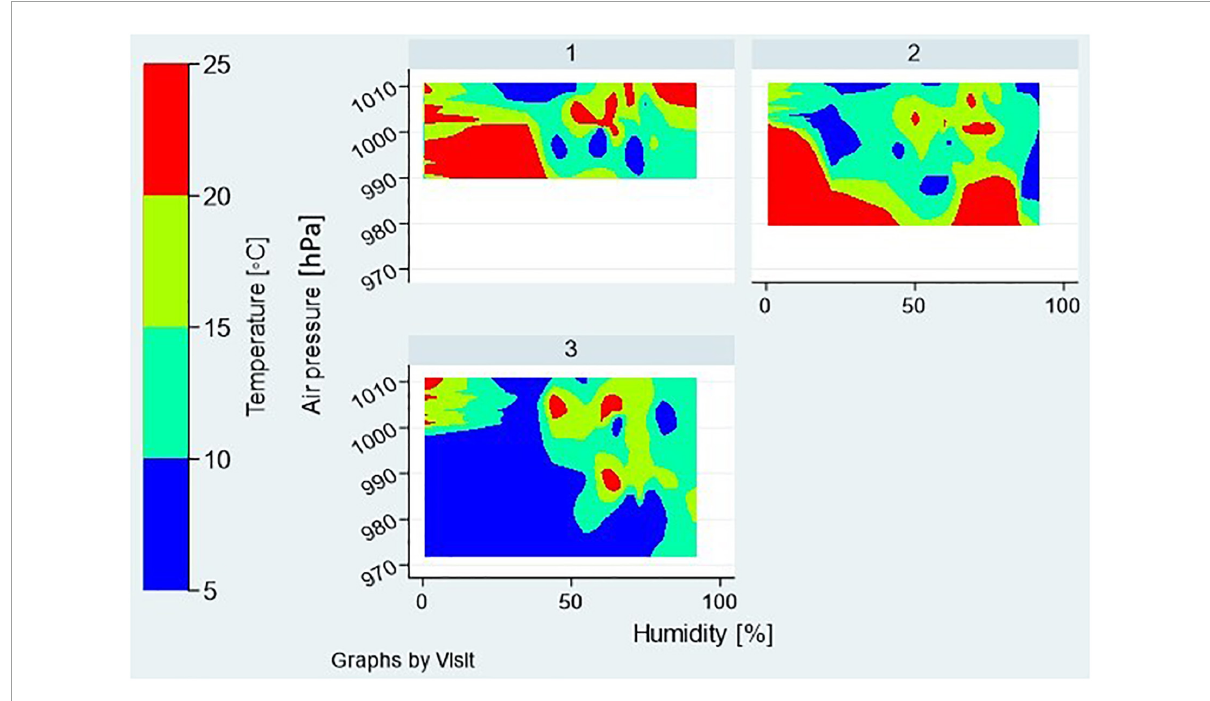
FIGURE3 Meteorological factors during the 3 visit days—distributions of outdoor temperature, air pressure, and relative humidity are shown as contour plots for all the participants’ visits assigned to a particular visit day—1, 2, or